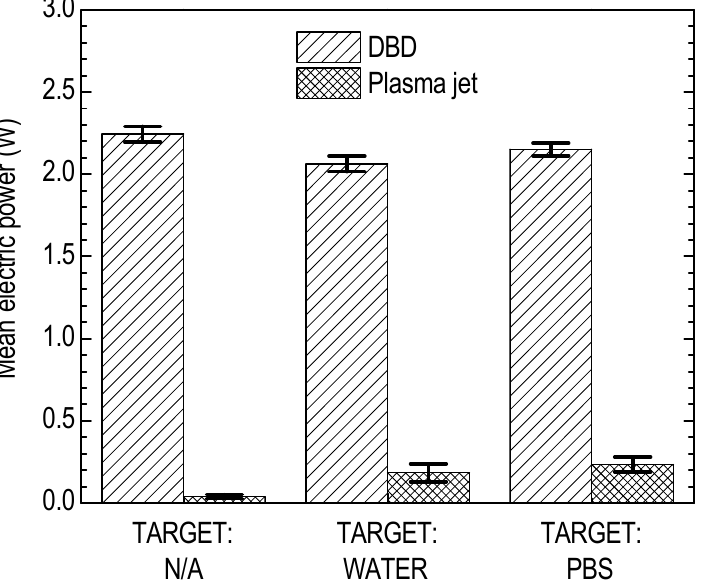
Figure 7. Distinction between the mean electric power consumed by the coaxial DBD and the plasma jet in three different cases: (i) free running plasma jet; (ii) plasma jet impinging onto water; (iii) plasma jet impinging onto buffer solution. Mean values and standard deviations are calculated from 30 (voltage × current) waveform pairs, with each pair to be recorded over 3 voltage periods. Operating conditions: 11 kV pp , 17.5 kHz, and 1.5